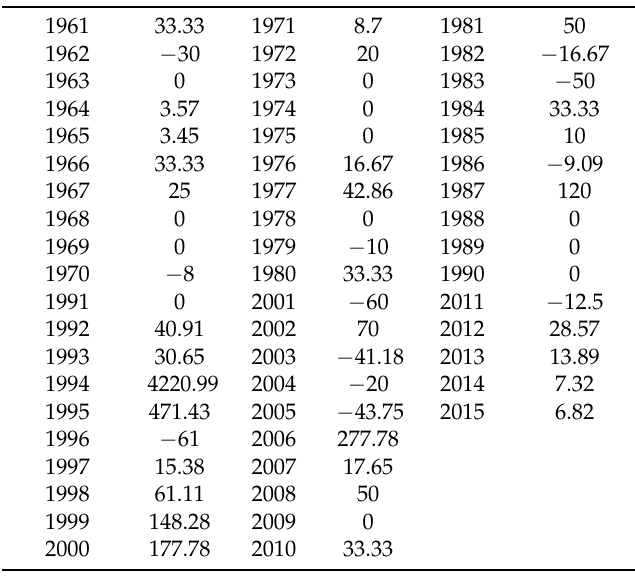
Table 2. Percentage changes in the median stamp price per year (sources: for the data until and including